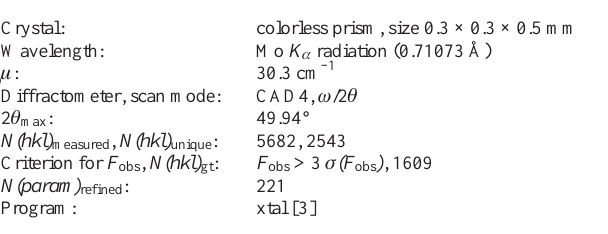
Table 1. Data collection and handling.